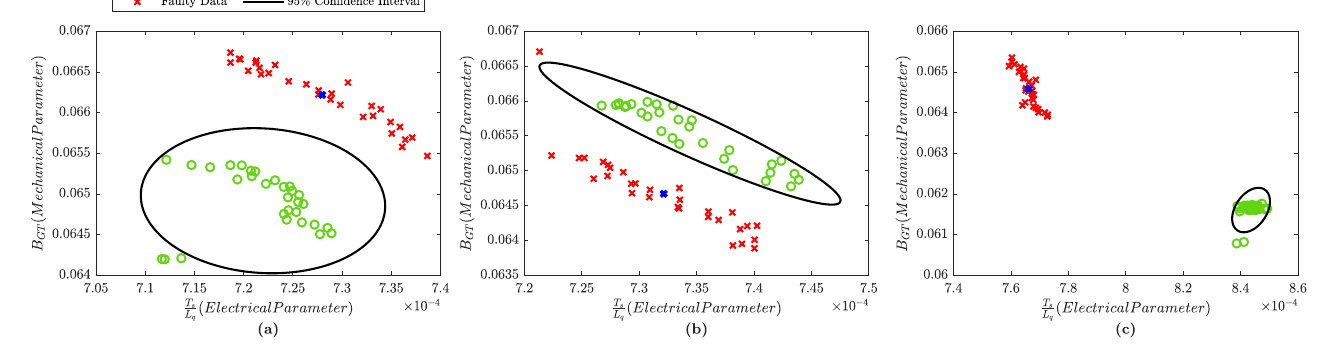
Figure 11. Sprocket–chain fault parameter clustering: ( a ) chain offset from the driving gear to the driven gear; ( b ) slightly worn damage at a tooth of the driven gear; ( c ) one missing tooth of the driven gear.